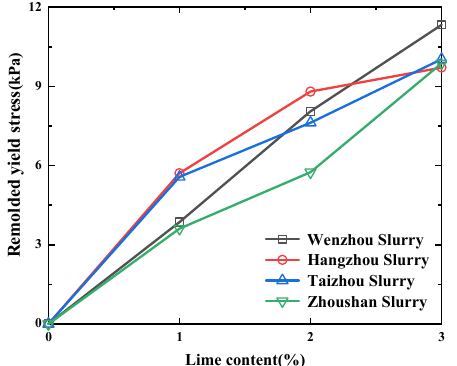
Figure 4. Remolded yield stresses of stabilized slurry for each group with di ff erent lime dosages.